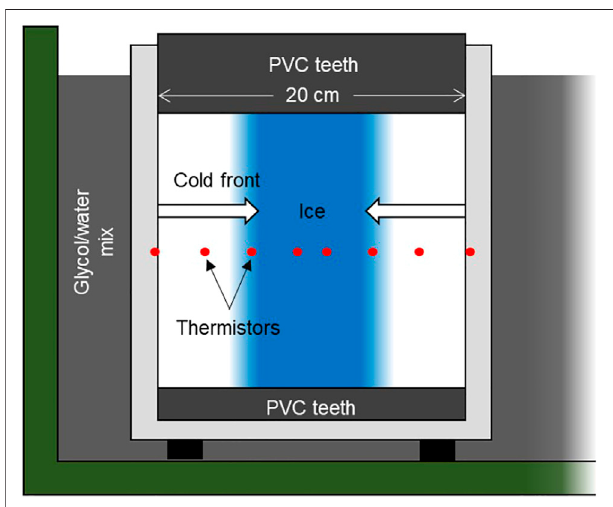
FIGURE 3 | Schematic cross-section through the ice chamber along a radius with a thermistor transect, showing freezing fronts induced by lowering the temperature of the glycol/water mixture surrounding the ice